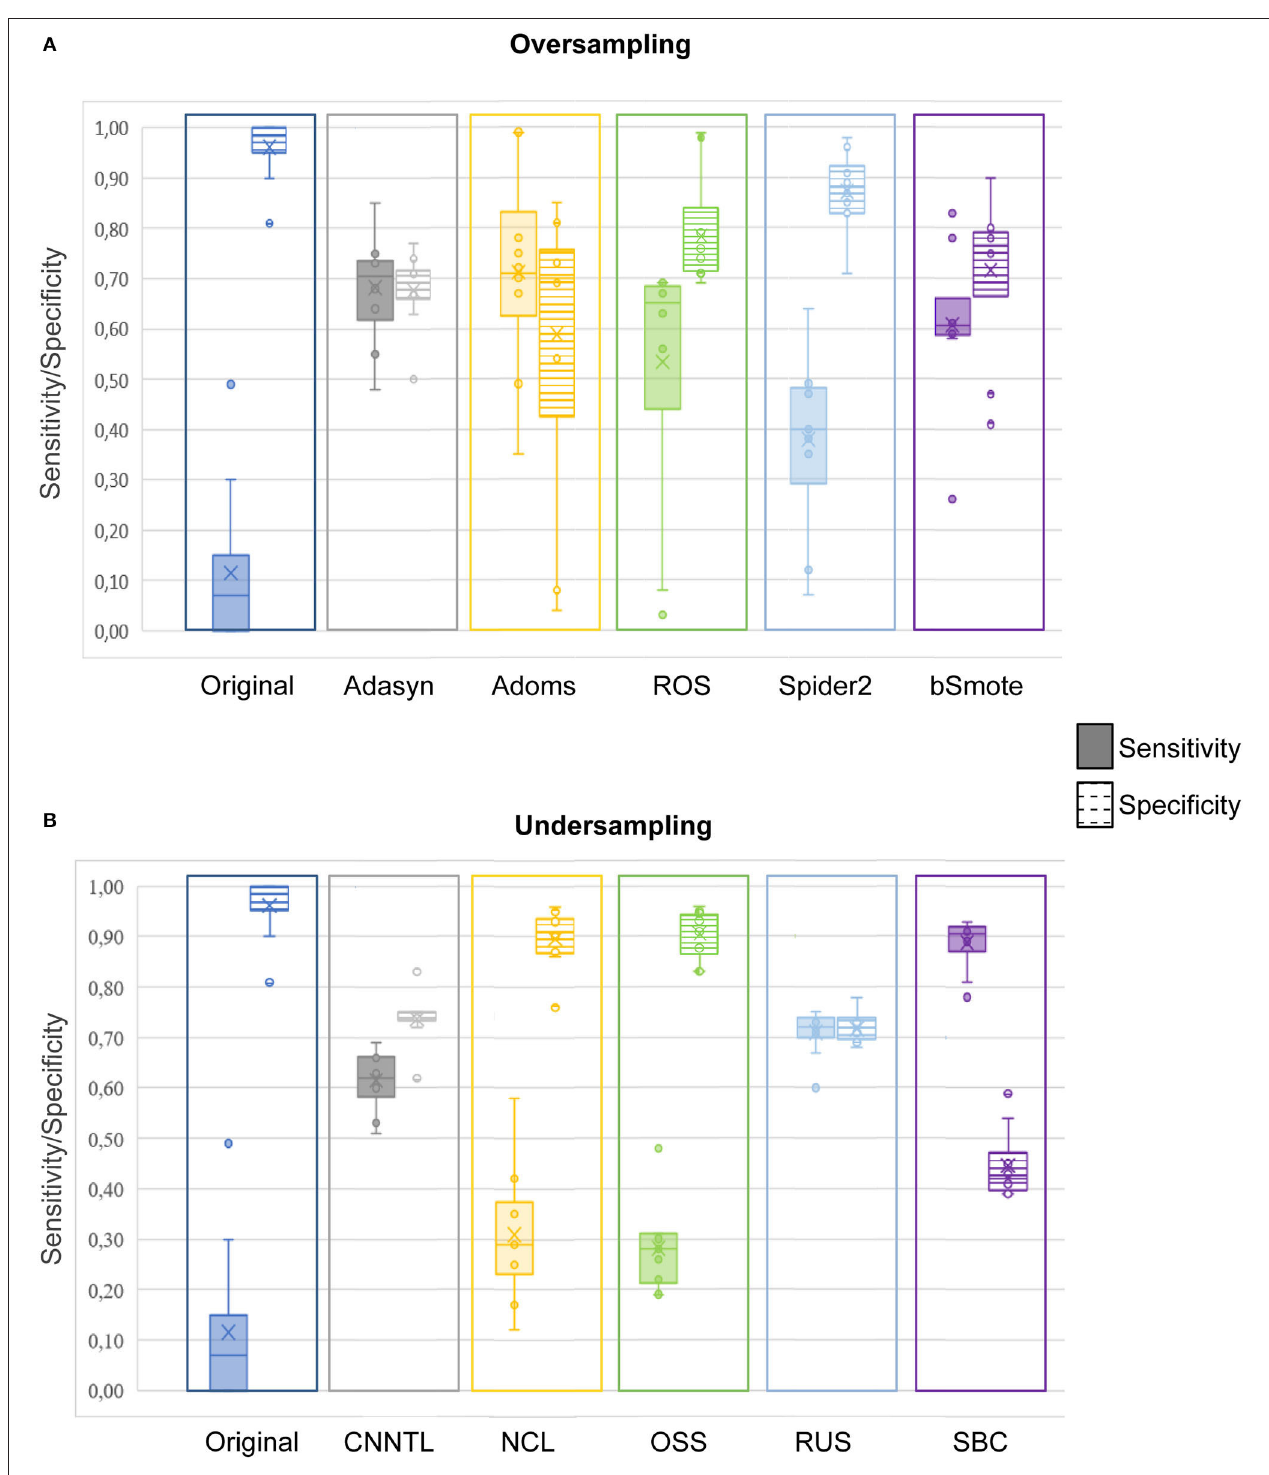
FIGURE 6 | Boxplot representing the values of sensitivity (full-color bars) and specificity (horizontal lines bars) for the original dataset and the five oversampling (A) and undersampling approaches (B) . Each box represents the variability among the 10 classification models. The middle line indicates the median value; upper and lower limits of the box indicate the first and third quartile; external points indicate outliers; x indicates the mean values. The corresponding values can be found in Table 6